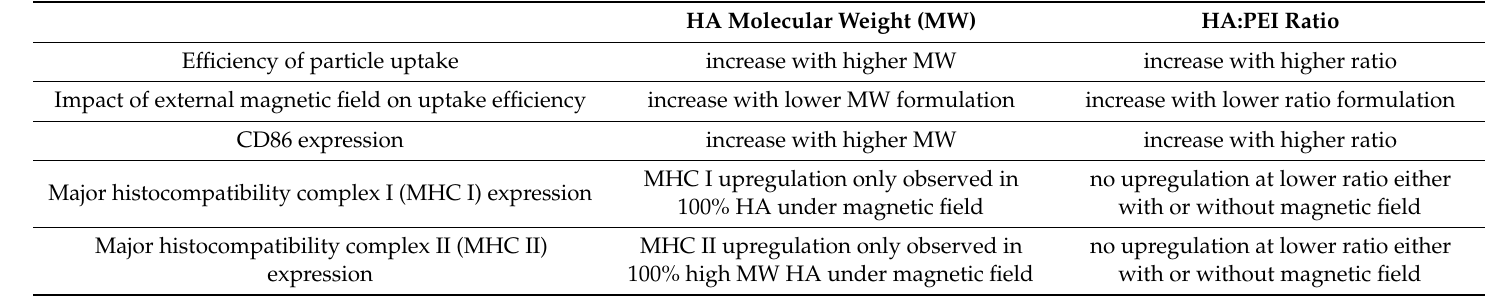
Table 2. The impact of molecular weight (MW) of HA and the HA:PEI ratio on particle uptake and regulation of dendritic cells (DCs) (for particle configuration: SPIONs/PEI/DNA +